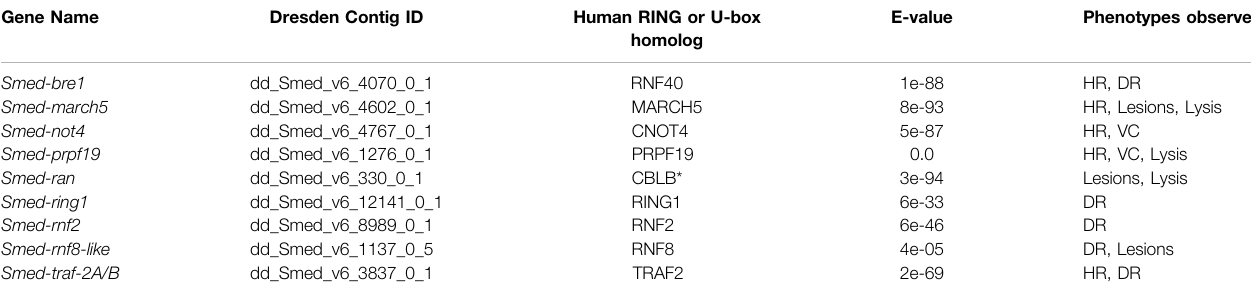
TABLE 1 | RING/U-box E3 ubiquitin ligases showing phenotypes following RNAi. Gene Name